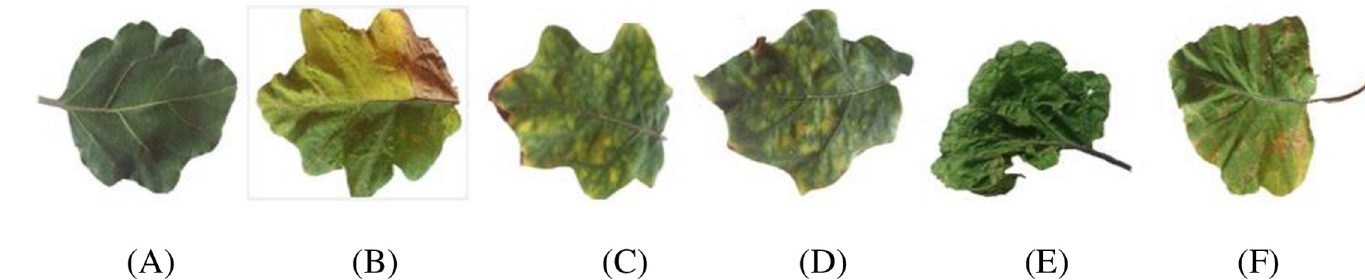
Fig 6. Fuzzy C Means clustering for brinjal leaf (a) Pseudomonas solanacearum (b) Cercospora solani (c) Alternaria melongenea (d) Pythium aphanidermatum (e) Tobacco Mosaic Virus .